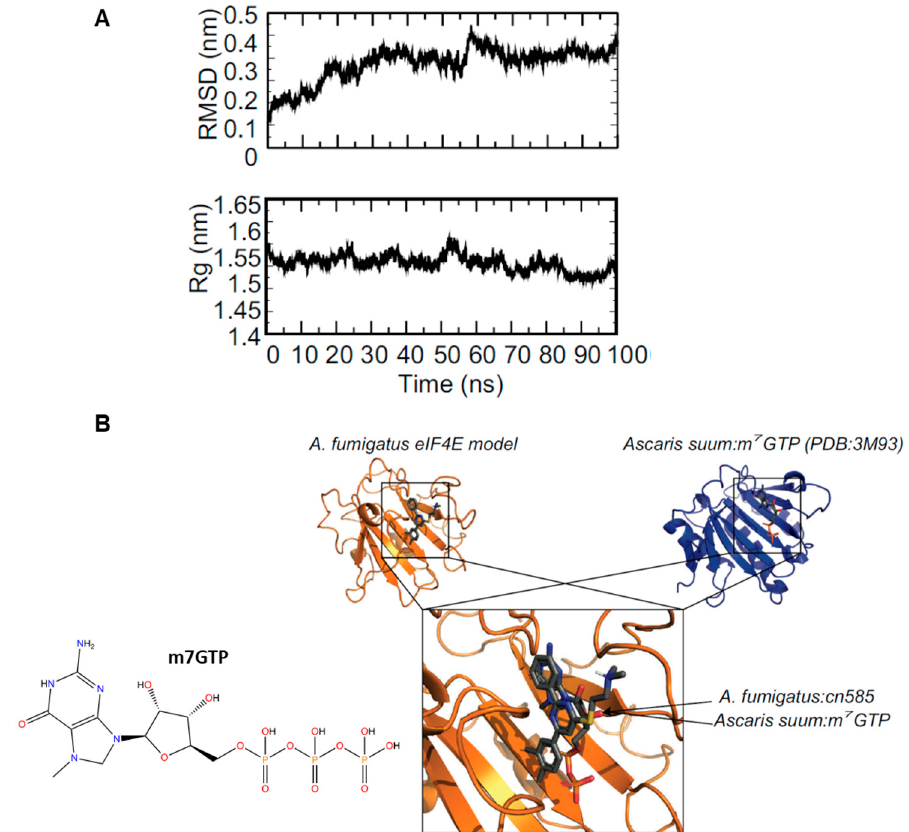
Figure 6. Molecular dynamics simulation and docking of A. fumigatus eIF4E to CN585. ( A ) MD simulation analysis showing the RMSD (top) and Rg (middle) of A. fumigatus eIF4E during the simulation. ( B ) Docking model of A. fumigatus eIF4E: CN585 (orange—left) compared to Ascaris suum eIF4E:m 7 GTP (blue—right). Overlay of the docking poses of CN585 and m 7 GTP is shown at the bottom. Labels provided for clarity.